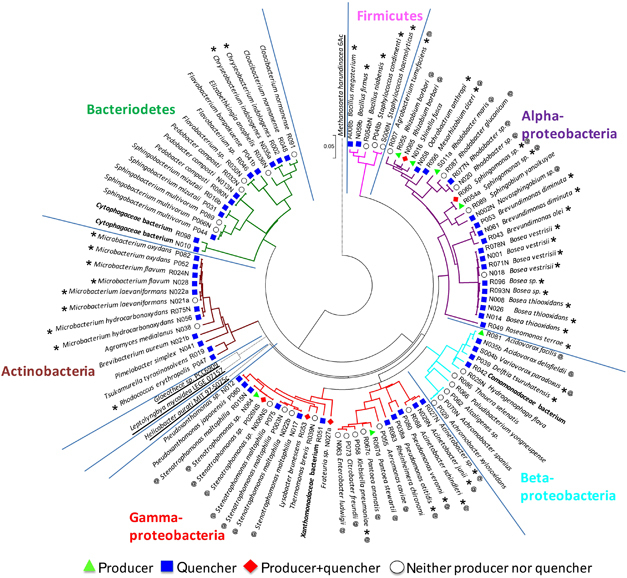
Evolutionary relationship of 100 representative bacterial isolates (taxa) based on the 16S rDNA gene sequences. Each representative was selected for their uniqueness in terms of N-acyl homoserine lactone (AHL) production and/or quenching properties. The evolutionary relationship was inferred using the neighbour-joining method. The bootstrap consensus tree inferred from 1,000 replicates was taken to represent the evolutionary relationship of the taxa analysed. Branches corresponding to partitions reproduced in <50% bootstrap replicates were collapsed. The tree was drawn to scale, with branch lengths reflecting evolutionary distances. The evolutionary distances were computed using the maximum composite likelihood method and are in the units of the number of base substitutions per site. All positions containing gaps and missing data were eliminated from the data set (complete deletion option). There were a total of 1,031 positions in the final data set. Phylogenetic analyses were conducted in MEGA4. The outgroups, retrieved from the GenBank database, are underlined. The isolated strains are classified as producer (green triangle), quencher (blue square), producer and quencher (red diamond) and neither producer nor quencher (open circle). The genera in which AHL production (@) or AHL degradation (*) activities have been reported in the literature are indicated. The closest relative with at least 97% sequence identity for each strain, except for those strains highlighted in bold, is shown.